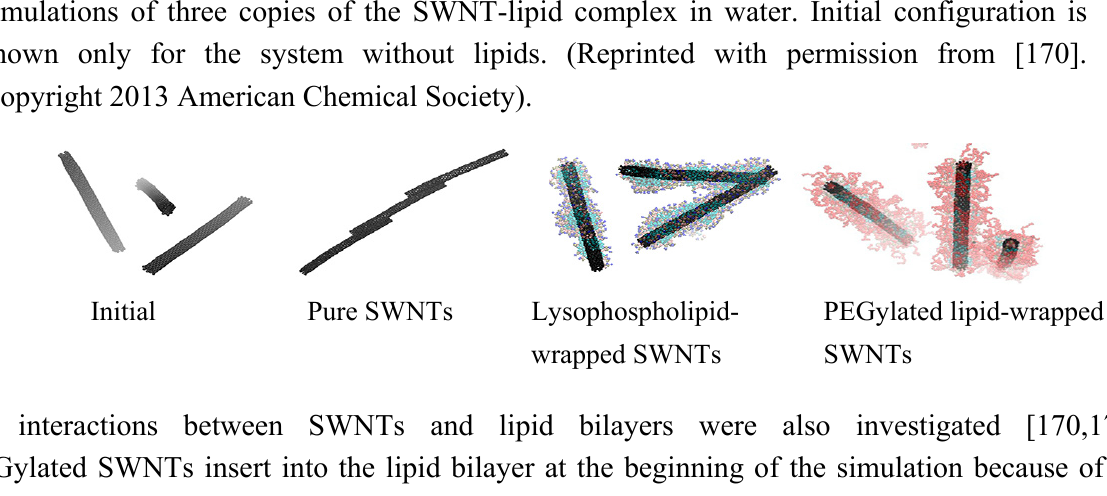
Figure 9. Snapshots at the beginning (0 ns, left) and end (500 ns, columns 2–4) of the simulations of three copies of the SWNT-lipid complex in water. Initial configuration is shown only for the system without lipids. (Reprinted with permission from